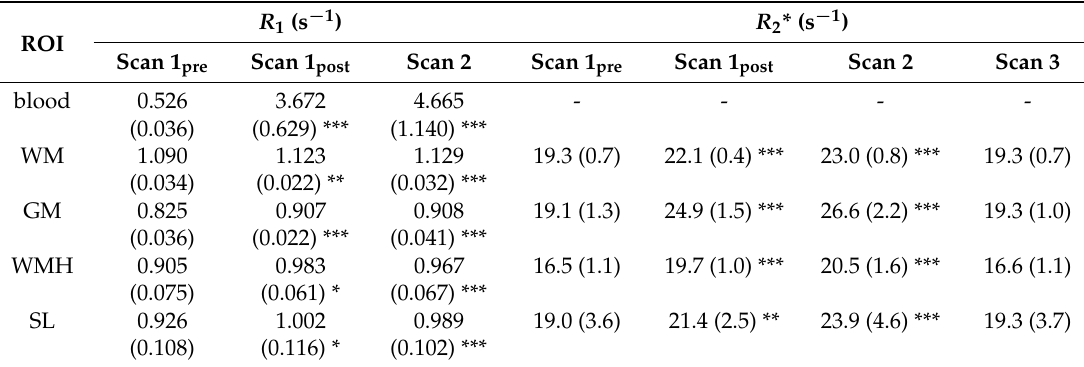
Table 2. Mean (standard deviation) relaxation rate values for each region of interest (ROI), averaged over patients. Statistically significant changes relative to baseline are indicated by * ( p < 0.05), ** ( p < 0.01) and *** ( p < 0.001).